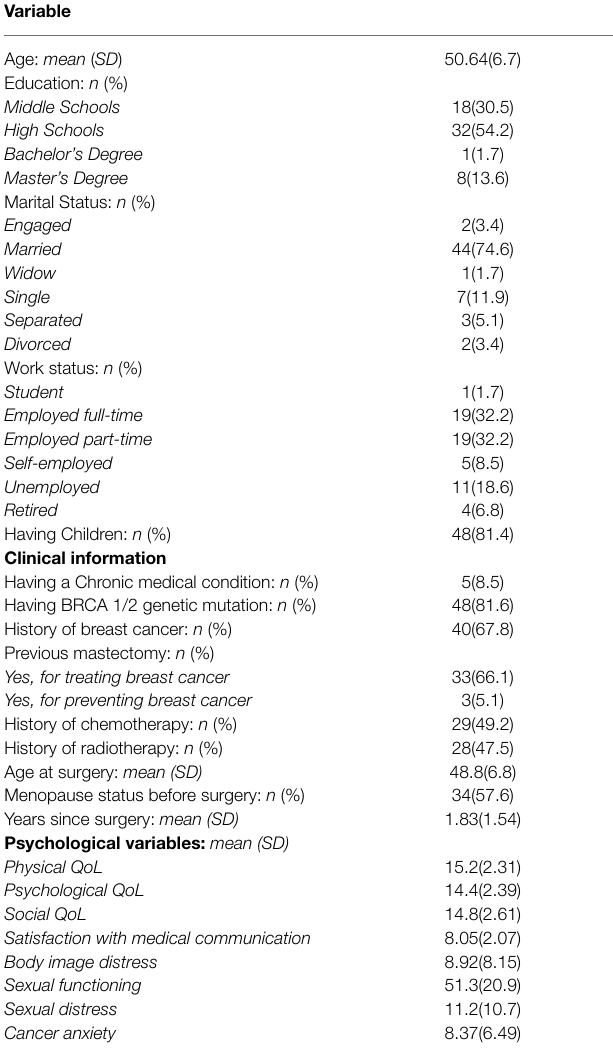
TABLE 1 | Frequencies, percentages, means, and standard deviations for all sociodemographic, clinical, and psychological variables examined in our sample of women who underwent Prophylactic Bilateral Salpingo-Oophorectomy (PBSO; N = 59).